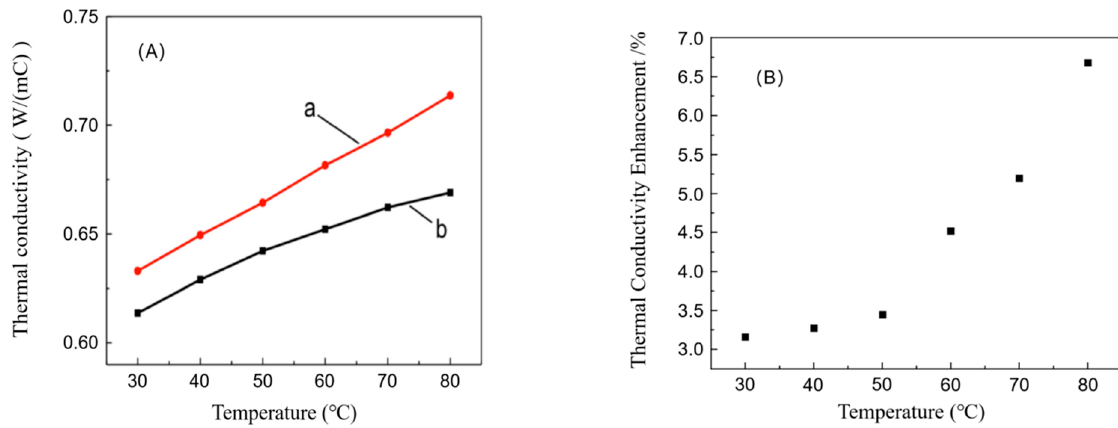
Figure 9. ( A ): The photographs of temperature-thermal conductivity curve of water (a) and nanofluids (b); ( B ): Thermal conductivity enhancement ratio of nanofluids in the different temperatures.